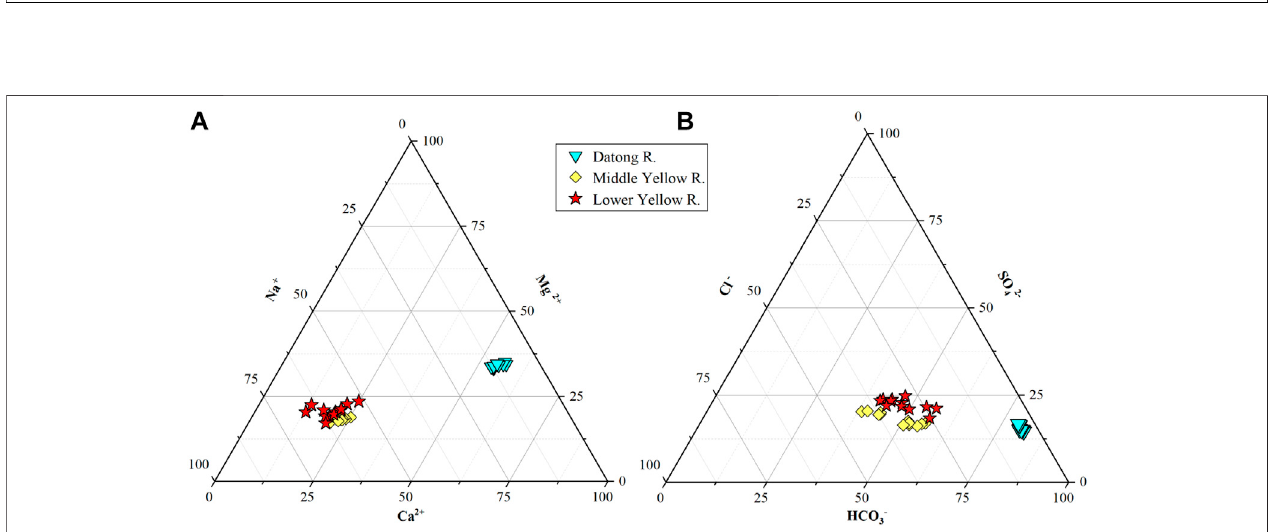
FIGURE 3 | Proportion of (A) major cations (B) major anions in river water of the Datong River basin. The middle reaches data (Longmen) come from Zhang et al. (2015) and the downstream data (Lijin) come from Ran et al. (2015).